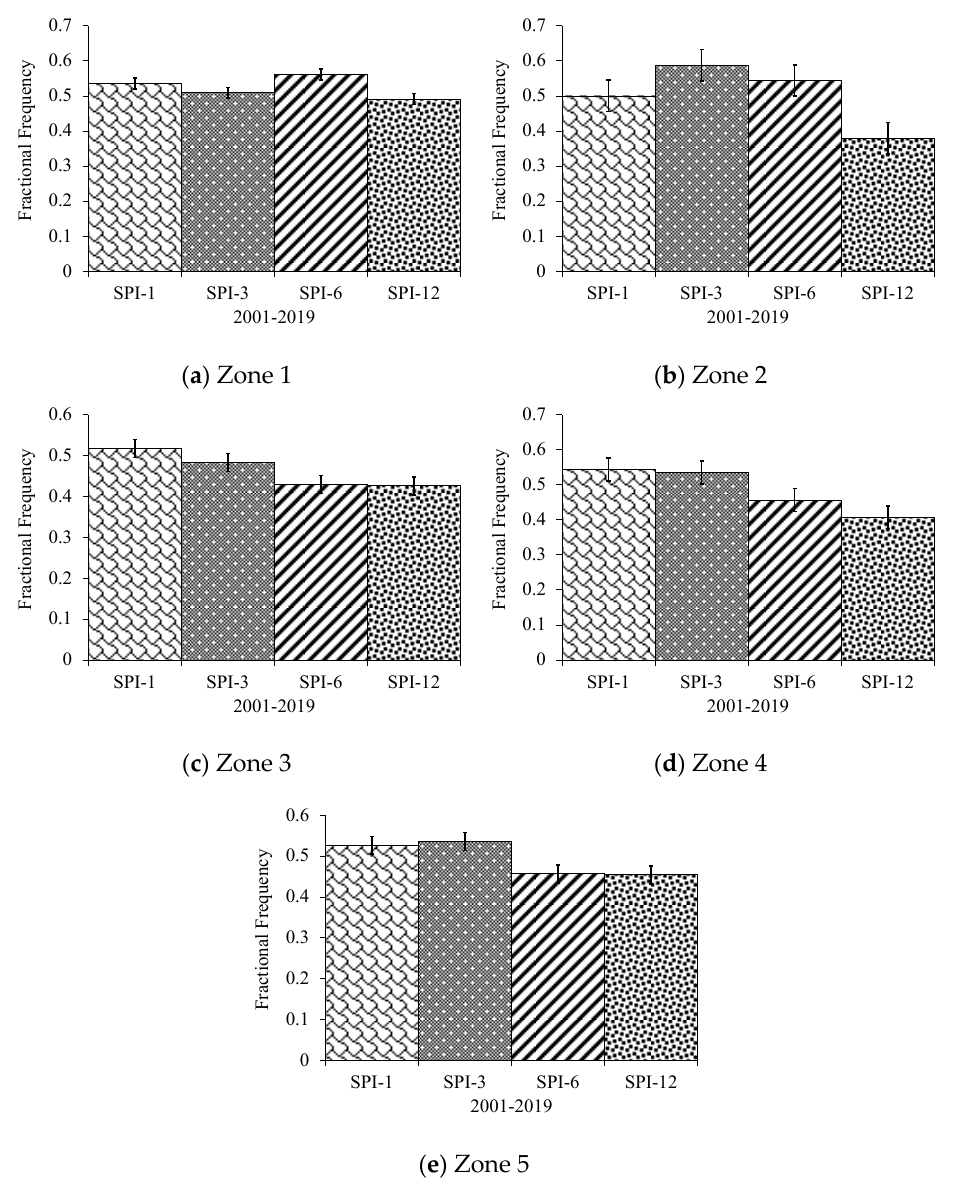
Figure 4. Fractional frequency of the Standardized Precipitation Index (SPI) for the wheat crop in different zones of Punjab, ( a ) Zone 1, ( b ) Zone 2, ( c ) Zone 3, ( d ) Zone 4 and ( e ) Zone 5